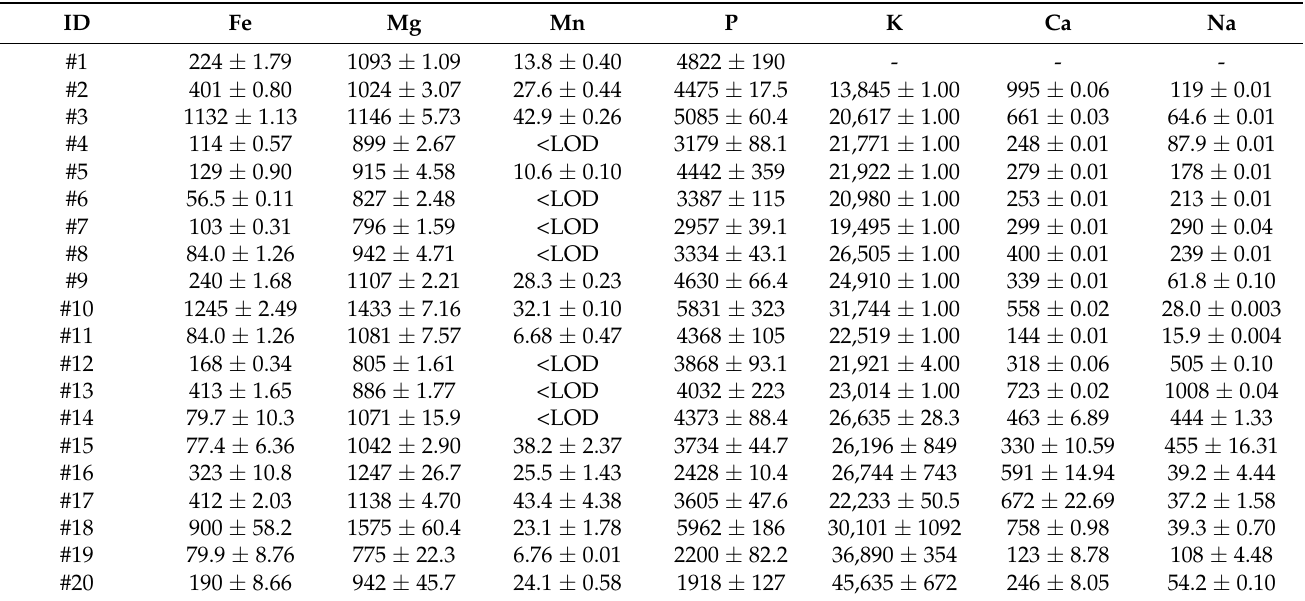
Table 3. Mineral content in samples of Lactarius mushrooms analyzed (mg Kg − 1 dry weight). Values are expressed as mean ± standard deviation ( n =